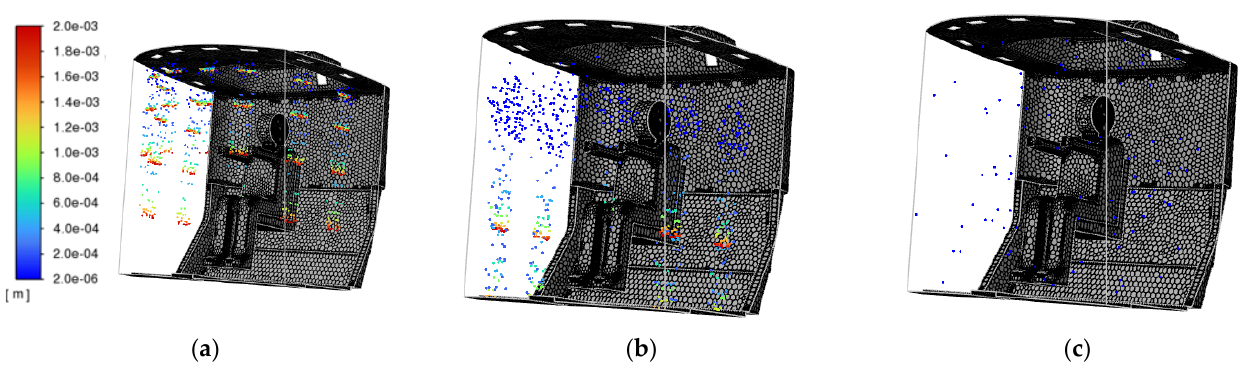
Figure 14. Trajectories and diameters of pathogen particles for deflectors versus time, the colors on the scale of values correspond to the size of particle diameters: ( a ) time 0.4 s; ( b ) time 1.2 s; ( c ) time 127 s.